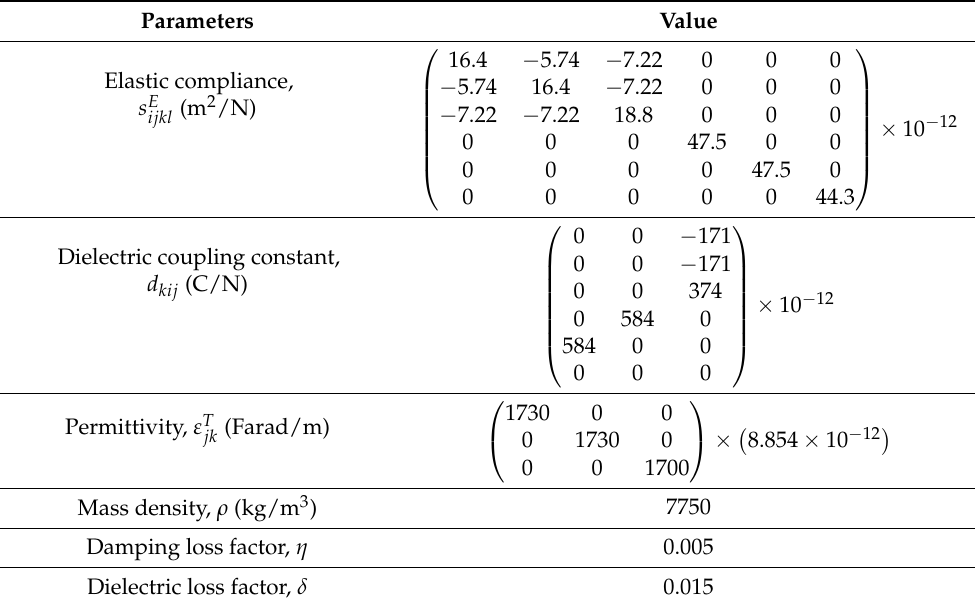
Table 2. Piezoelectric properties of the PZT-5A